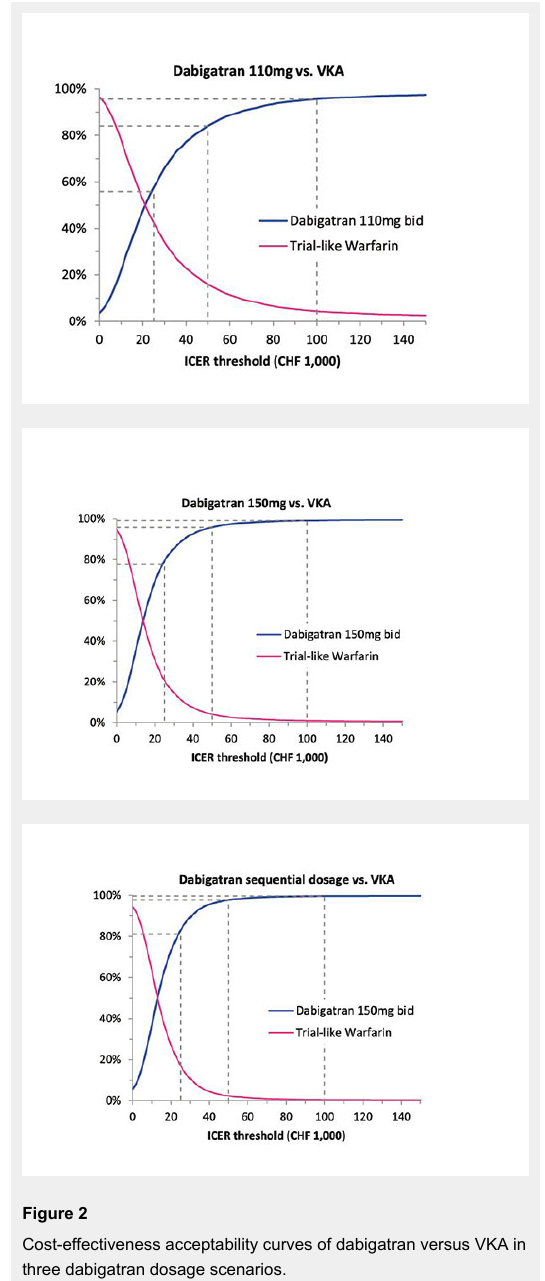
Figure 2 Cost-effectiveness acceptability curves of dabigatran versus VKA in three dabigatran dosage scenarios. The cost-effectiveness acceptability curve (CEAC) of dabigatran shows the probability of dabigatran to be the cost-effective treatment versus the alternative VKA treatment at different ICER thresholds. The CEAC is generated on the basis of 10,000 PSA model runs. A point on the line can be interpreted as the probability to correctly choose dabigatran as the cost-effective drug at a determinate ICER threshold. The dotted lines indicate these probabilities at thresholds of CHF 25,000.‒, CHF 50,000.‒, and CHF